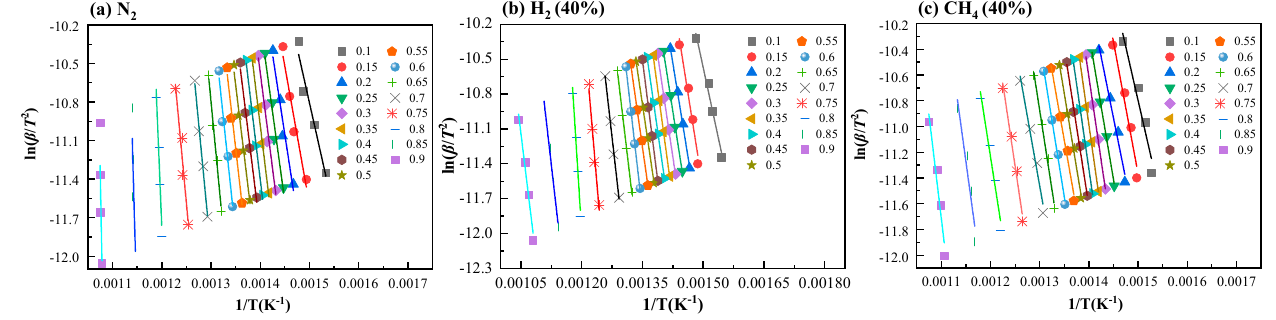
Figure 6. Different conversion α Arrhenius curve of coal: ( a ) N 2 atmosphere; ( b ) H 2 (40%) atmosphere and; ( c ) CH 4 (40%) atmosphere.